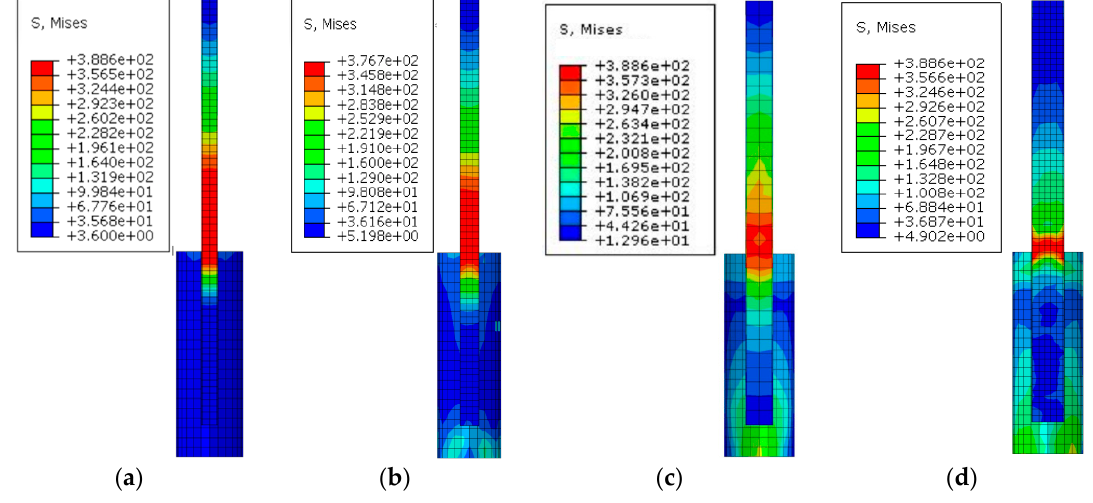
Figure 21. The stress cloud of steel tube for specimen LS at failure: ( a ) LS-1; ( b ) LS-2; ( c ) LS-3; ( d ) LS-4.